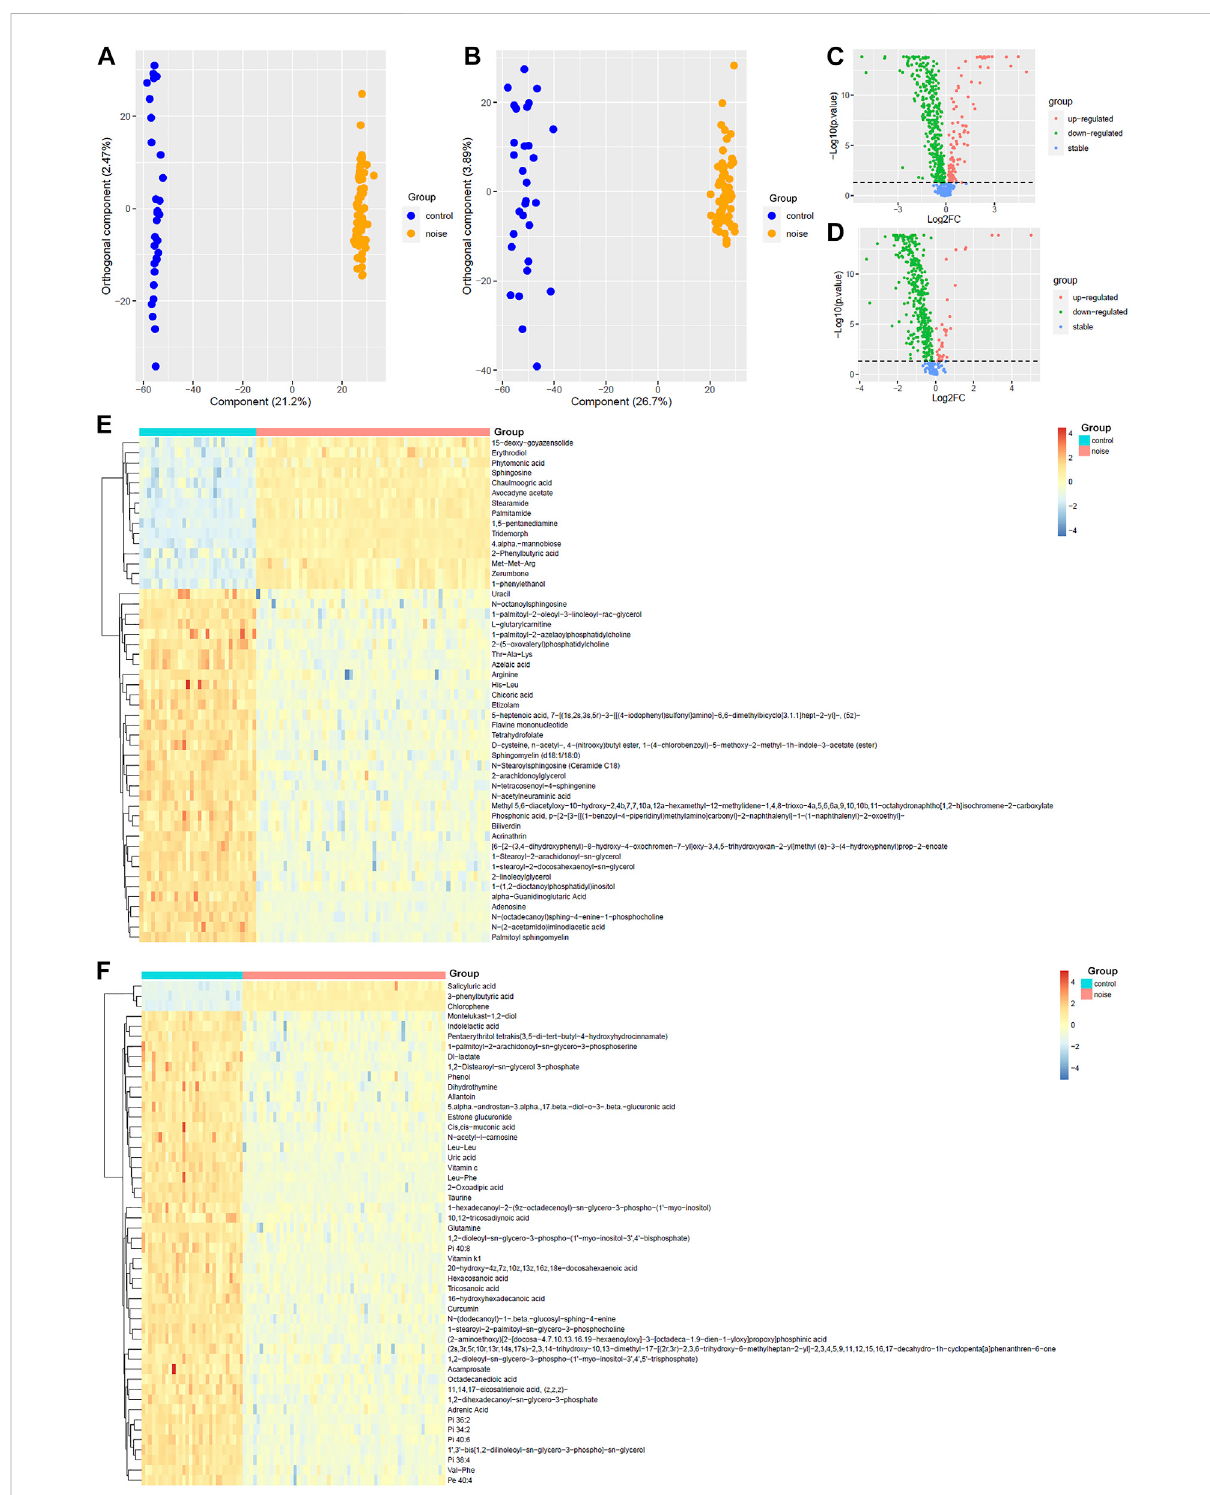
FIGURE 2 OPLS-DA of the plasma metabolites between the noise group and control group. (A,B) OPLS-DA score plots between the noise group and control group in positive and negative ion modes, respectively. (C,D) Comparisons of the metabolites between the noise group and the control group in the positive and negative mode, respectively. (E,F) Top 50 differential metabolites with the smallest p values and VIP > 1 between the noise group and the control group in the positive ion mode and negative ion mode, respectively. The Wilcoxon test and OPLS-DA were used for analyses, and they were performed in R 4.0.3 software. The metabolites with p < 0.05 in the Wilcoxon test and VIP > 1 in the OPLS-DA were considered signi fi cant. OPLS-DA, orthogonal partial least squares discrimination analysis; VIP, variable importance in projection; log 2 FC, log 2 (fold